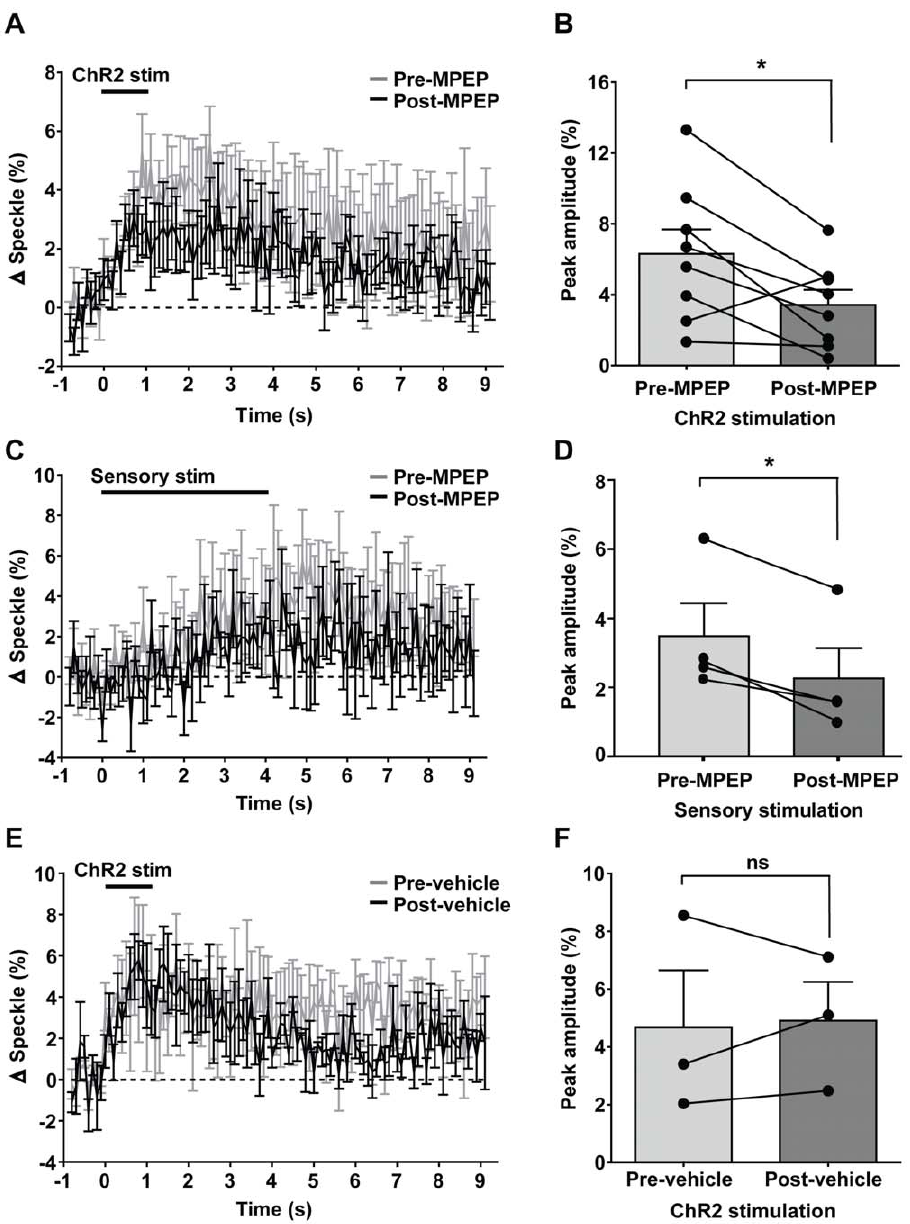
Figure 5. ChR2-evoked and sensory-evoked changes in blood flow are partially reduced by the mGluR5 antagonist MPEP. A, Temporal profiles of laser speckle responses evoked by 1 s of ChR2 stimulation before and after antagonist incubation. B, Comparison of peak amplitudes (averaged over 1 s) in laser speckle contrast responses in (A) before and after antagonist incubation. A significant difference was observed (n=8, paired t-test, p=0.0251). C, Temporal profiles of laser speckle responses evoked by sensory stimulation before and after antagonist incubation. D, Comparison of peak amplitudes (averaged over 1 s) in laser speckle contrast responses in (C) before and after antagonist incubation. A significant difference was observed (n=4, paired t-test, p=0.0155). E, Temporal profiles of laser speckle responses evoked by ChR2 stimulation before and after injection of saline vehicle. F, Comparison of peak amplitudes (averaged over 1 s) in laser speckle contrast responses in (E) before and after saline injection. No significant difference was observed (n=3, paired t-test, p=0.8211). Error bars represent